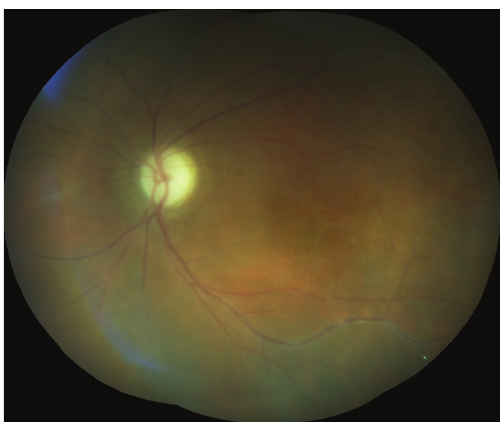
Figure 4: Retinal vasculitis, disc atrophy, and macular edema in patient with MS (left eye).